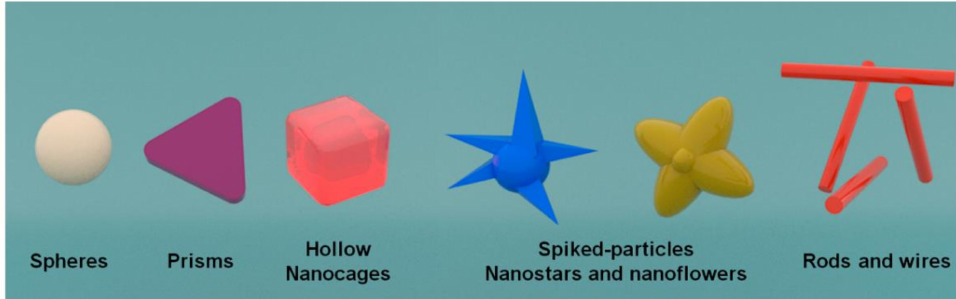
Figure 1. Schematic representation of the different NPs morphologies used for the surface modifica- tion of